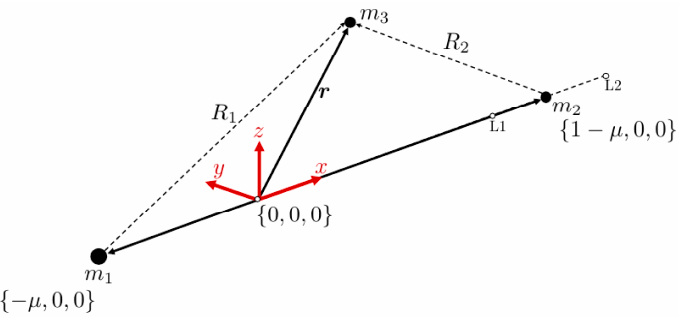
Figure 1. Geometry of the circular-restricted three-body problem where the secondary body, m 2 , is in a circular orbit around the primary body, m 1 . The third-body, whose mass is m 3 (cid:28) m 2 < m 1 , is negligible and at a distance R 1 from m 1 , R 2 from m 2 , and r from the system’s barycenter (the system’s center of